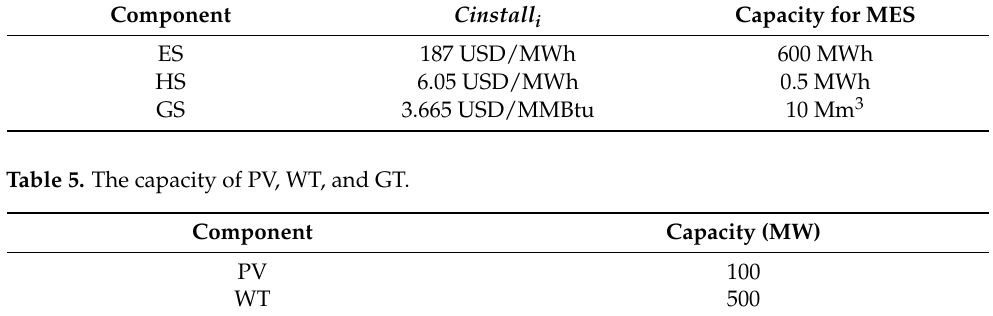
Table 4. The installation cost coefficient and capacity for storage devices.